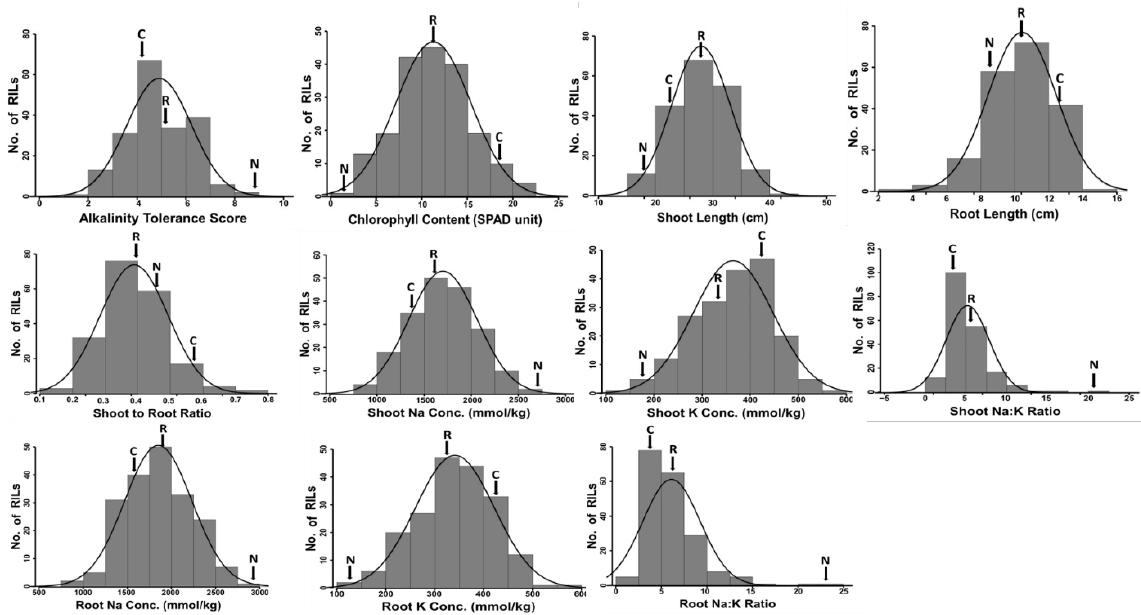
Figure 2. Frequency distribution of Cocodrie/N22 RIL population for seedling stage alkalinity tolerance for various morphological and physiological traits. The arrowhead indicates the trait mean for Cocodrie (C), N22 (N), and RIL population (R).